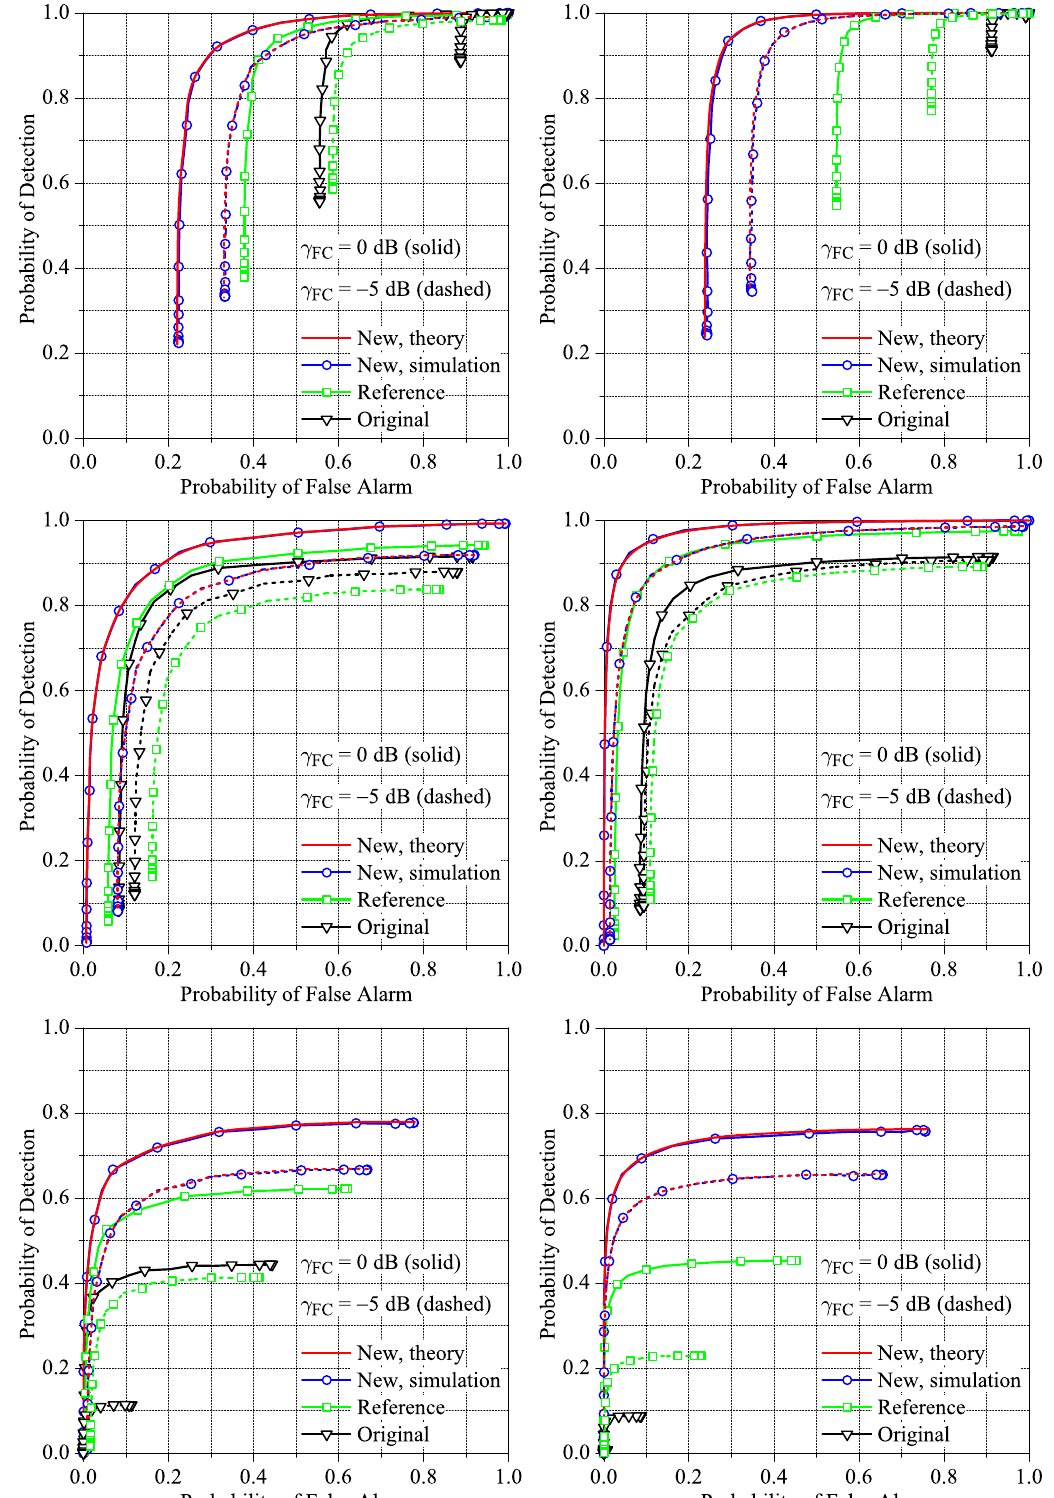
Figure 6. ROC curves at the fusion centre (FC) for M = 3 ( Left ), M = 5 (right), K = 1 ( Top ), K = (cid:100) M/ 2 (cid:101) ( Middle ) and K = M ( Bottom ), γ